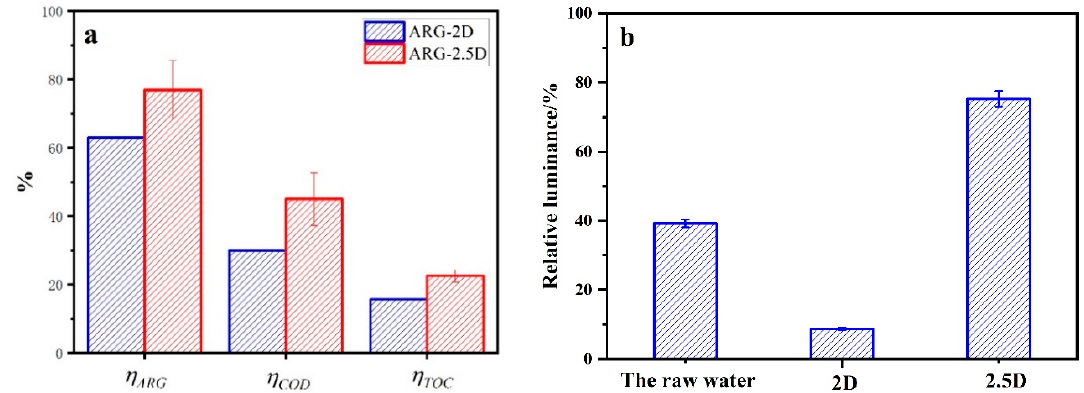
Figure 4. The removal e ffi ciency ( a ) and relative luminance before and after electrolysis ( b ) of Acid Red G (ARG) by 2.5D and 2D electrode (electrolysis condition: ARG 100 ppm, 10 mA / cm 2 , 0.1 mol / L Na 2 SO 4 , room temperature, and electrolysis time of 1